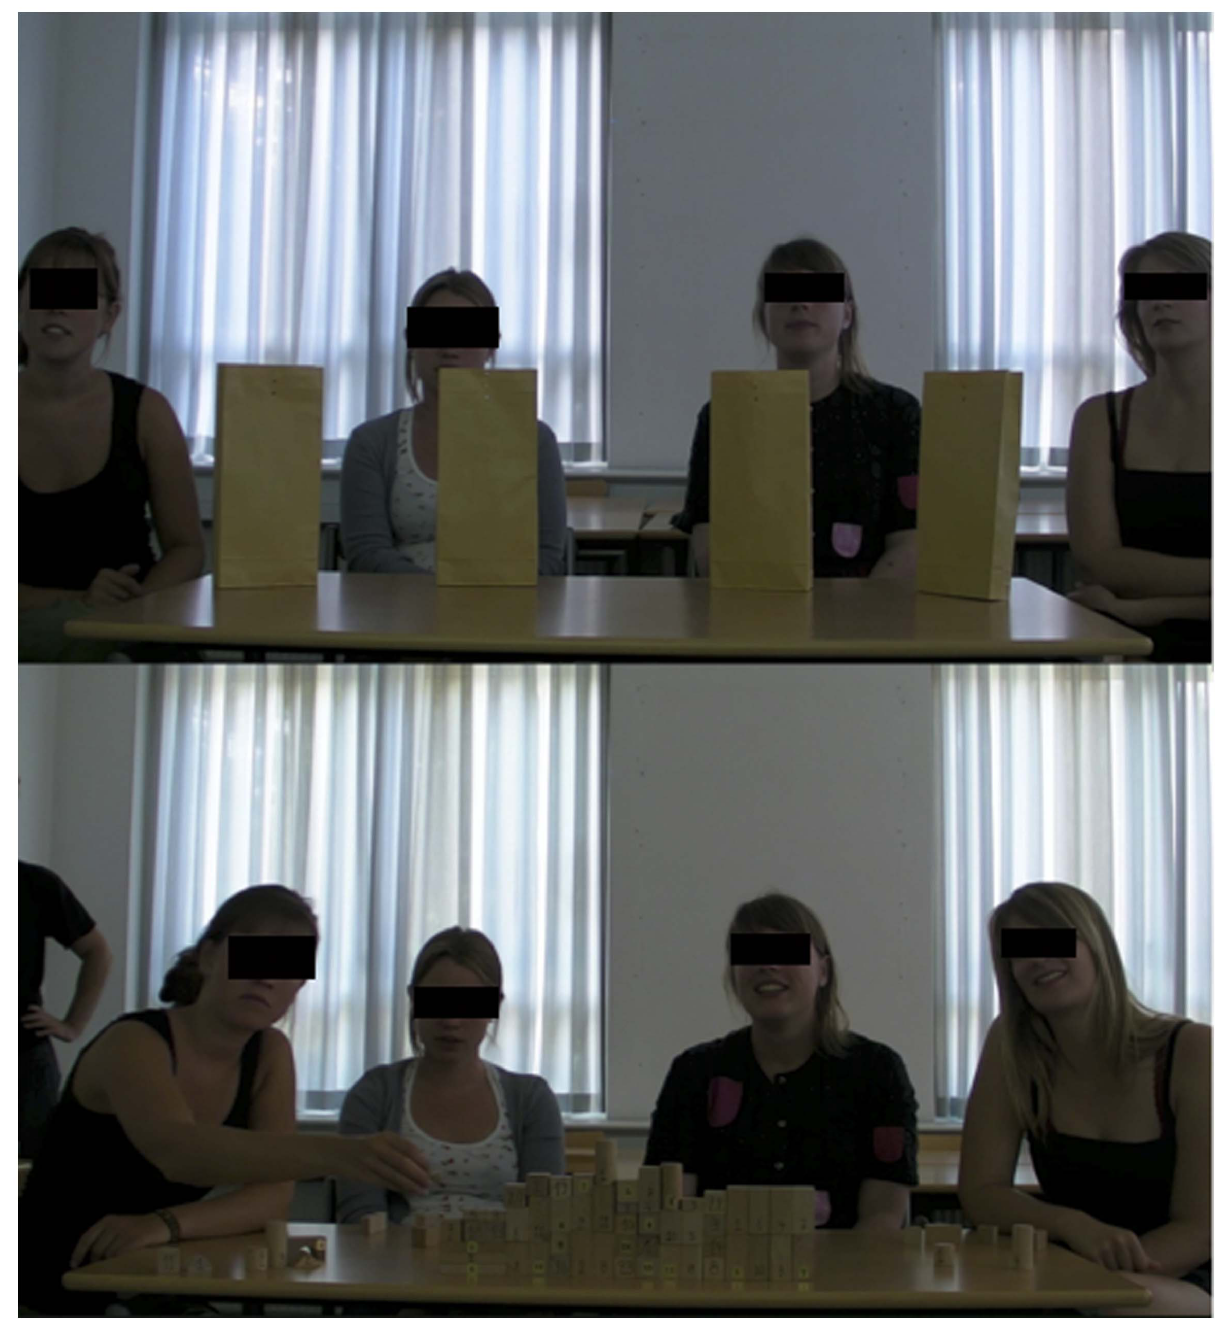
Figure 2. Participants during the manipulation task.